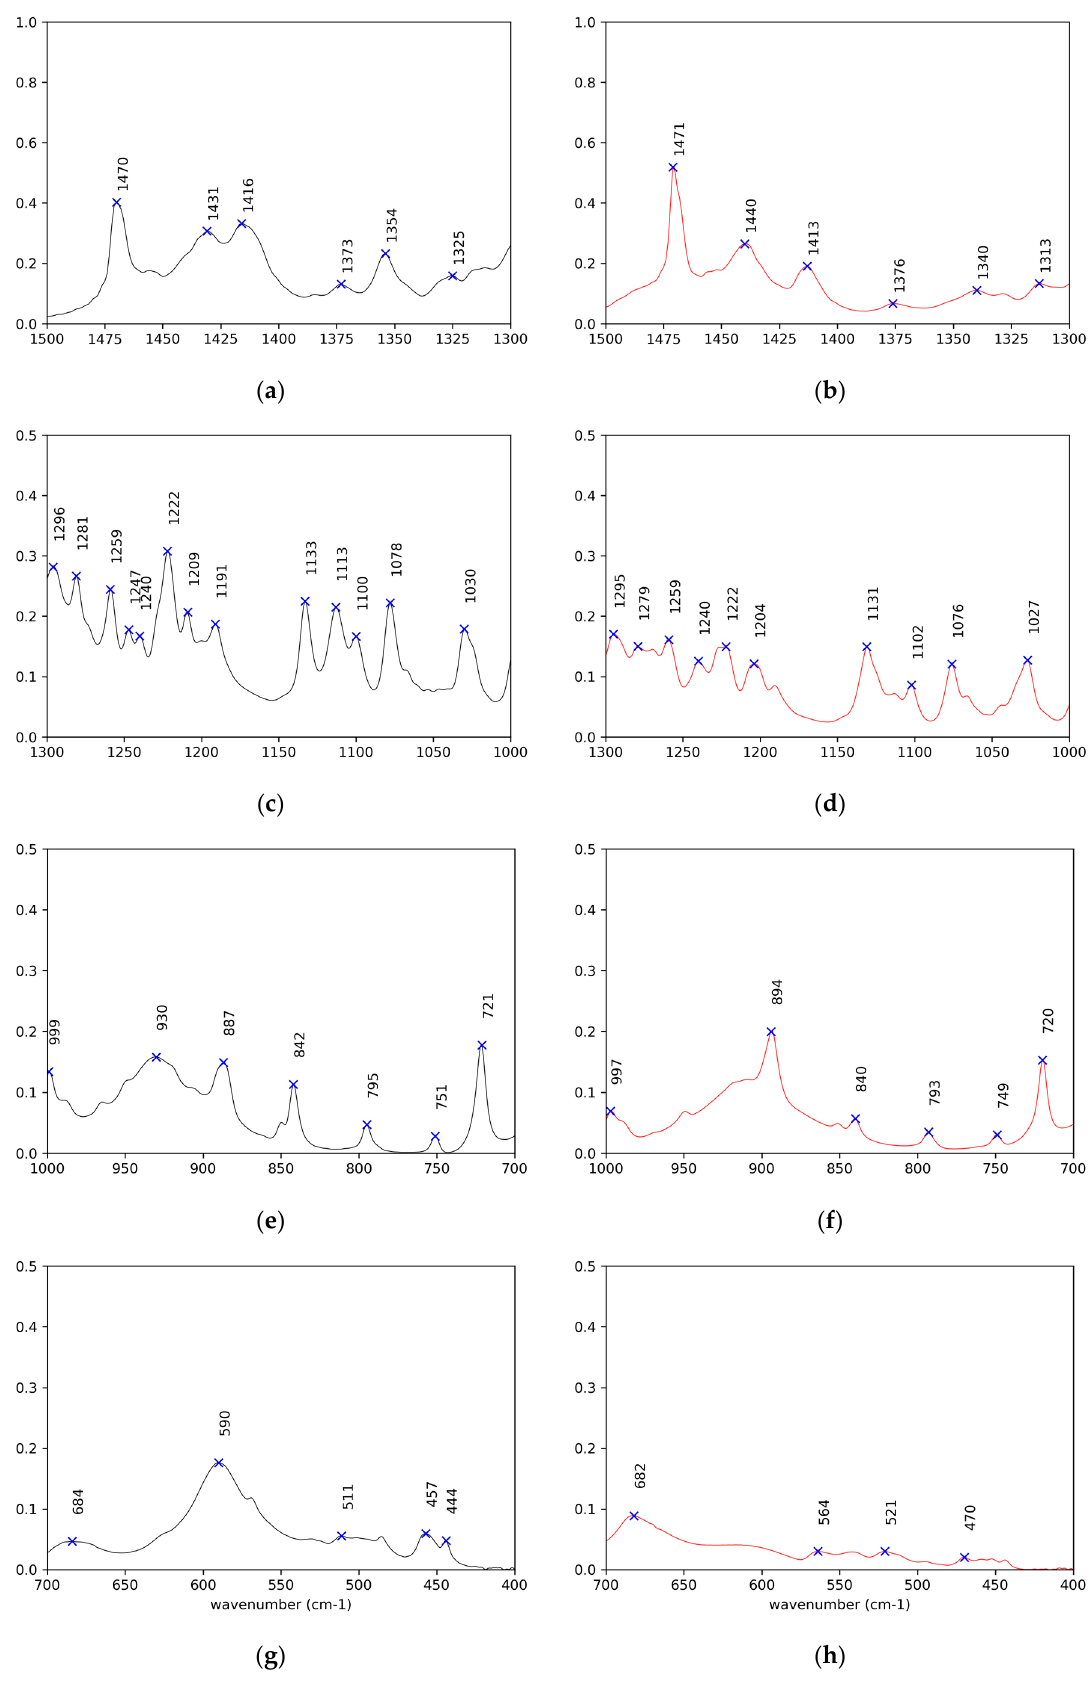
Figure 6. Enlargements of the IR spectra in the fingerprint region ( a , c , e , g ) for ( R )-10-HSA crystals, on the left in black, and ( b , d , f , h ) for the heat-treated sample, on the right in red.